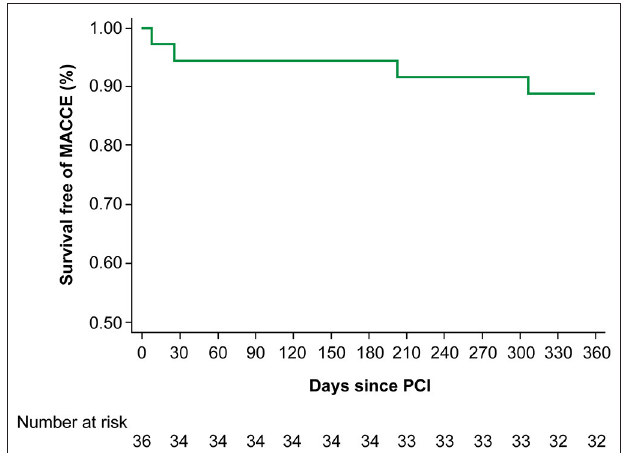
FIGURE 1 | The incidence of MACCE within 12 months of PCI. MACCE, major adverse cardiovascular and cerebrovascular event; PCI, percutaneous coronary